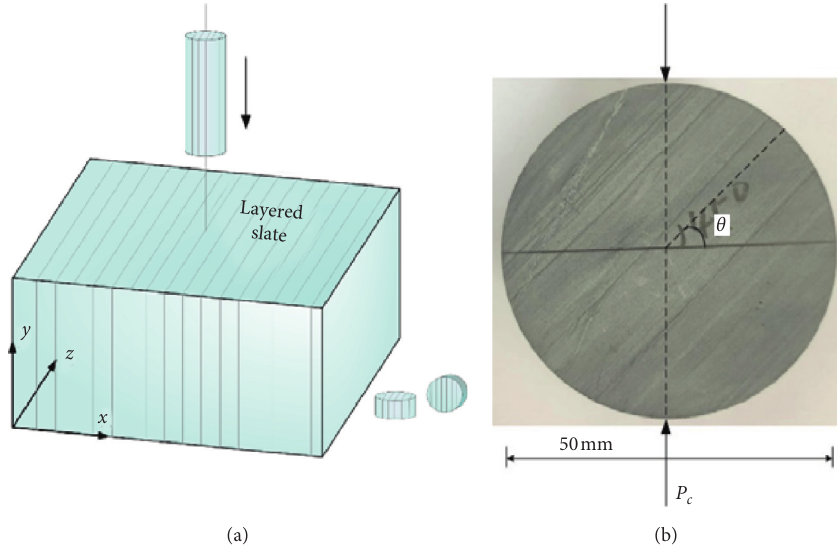
Figure 3: Brazilian test sample preparation. Table 1: Uniaxial compressive strength.